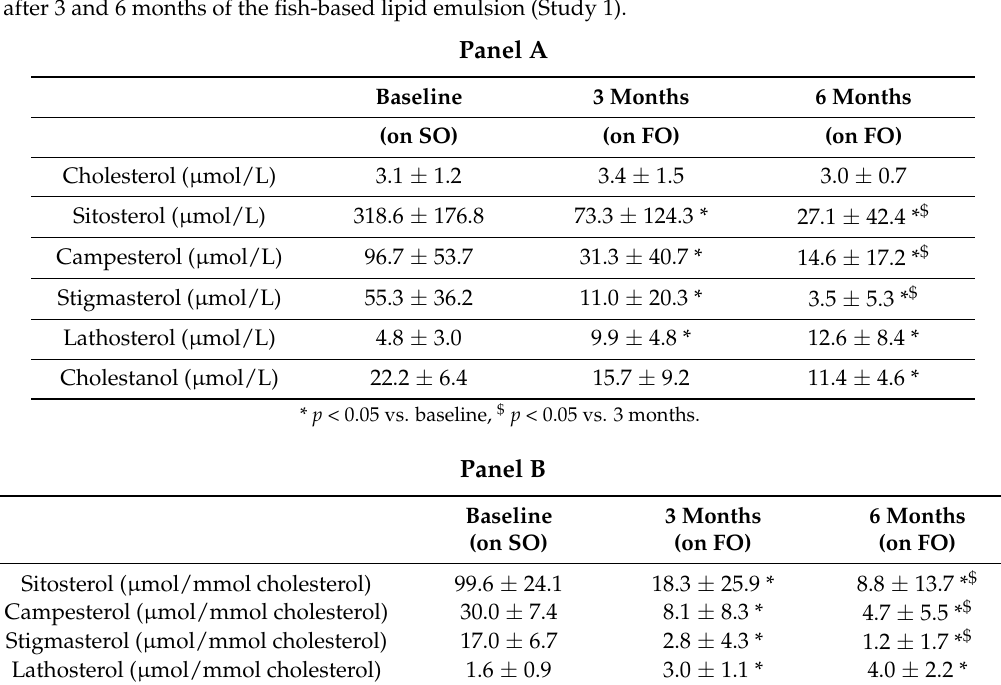
Table 4. Serum non-cholesterol sterol concentrations, absolute ( µ mol/L) in panel A, and cholesterol standardized ( µ mol/mmol cholesterol) in panel B, at baseline (on the soy-based lipid emulsion) and after 3 and 6 months of the fish-based lipid emulsion (Study